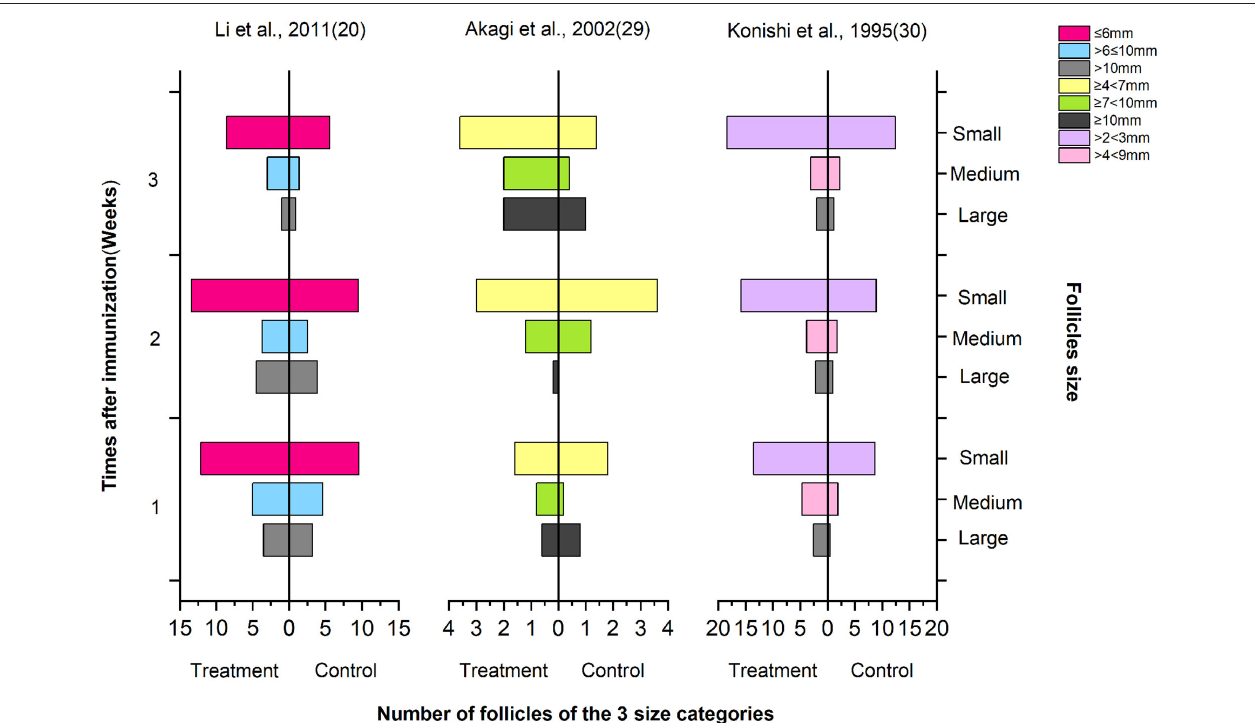
FIGURE 5 | Number of follicles of the three size